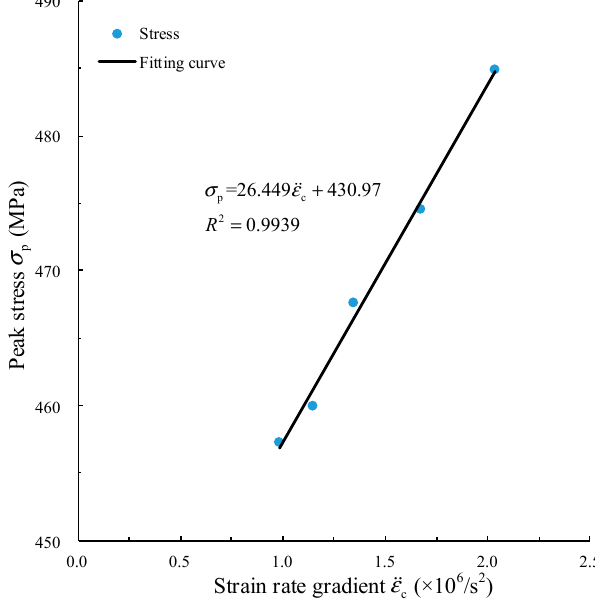
Figure 12. Fitting relation between peak stress and strain rate gradient. The fitting relation between peak stress σ p and strain rate gradient Equation